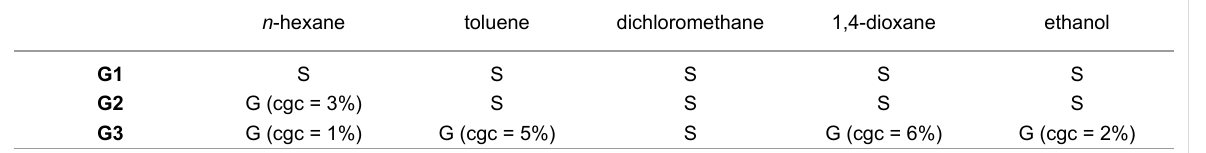
Table 1: Gelation of organic solvents by the amphiphilic dendritic oligopeptides a . n -hexane